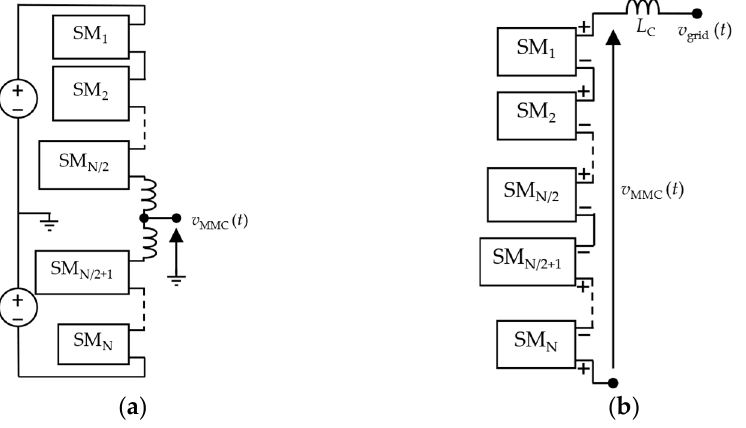
Figure 2. Block diagram for ( a ) traditional and ( b ) proposed MMC topology.